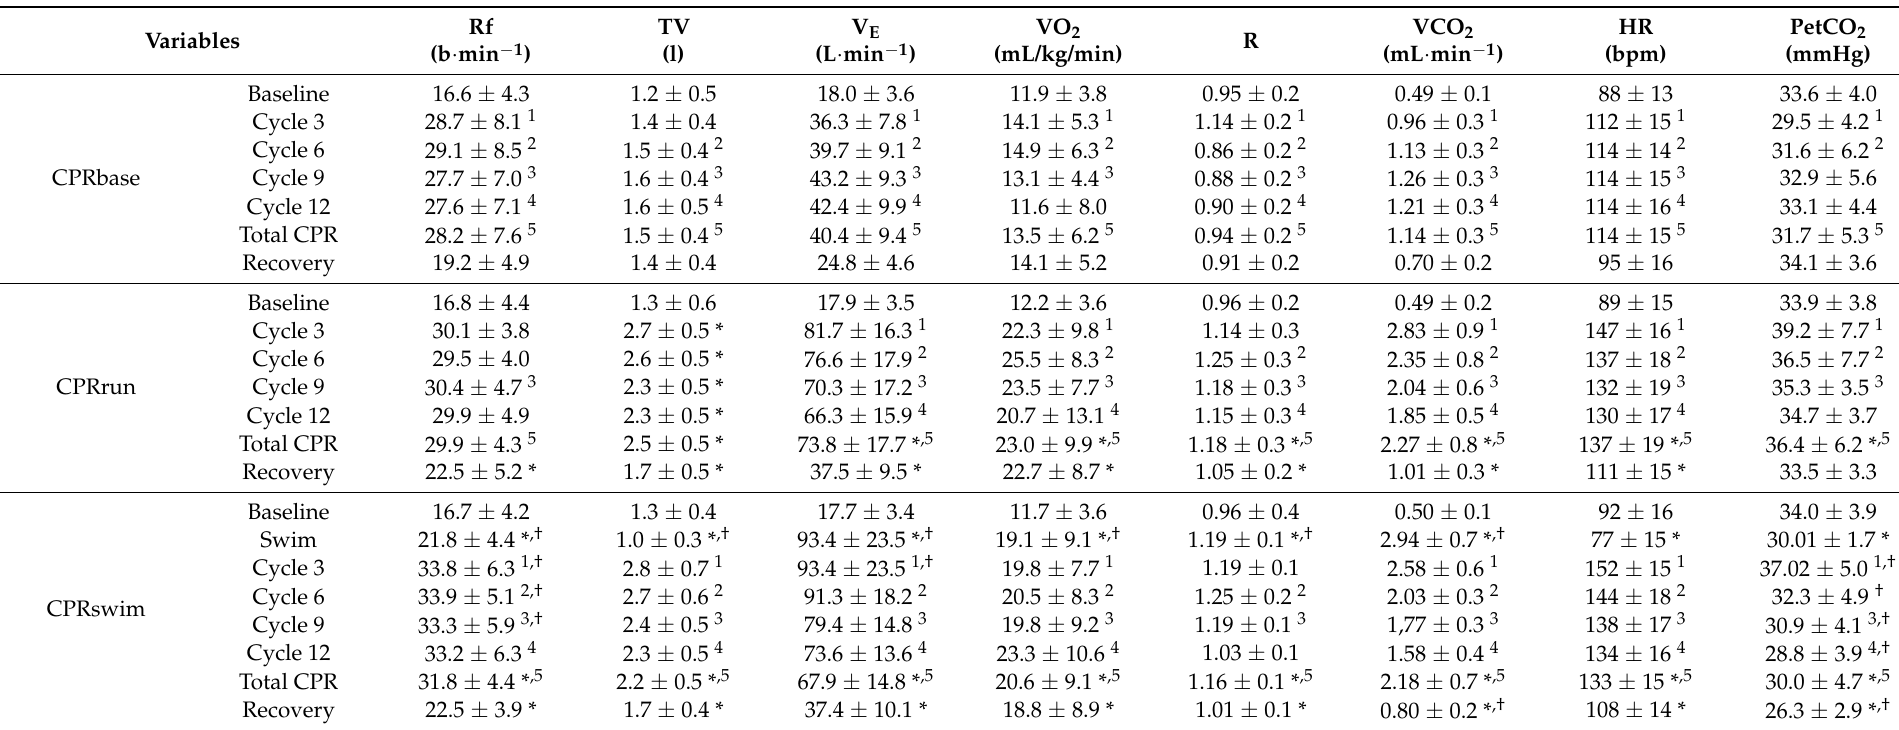
Table 1. Mean ± SD values for the cardiopulmonary variables assessed during baseline, CPR cycles, total CPR and recovery in the different experimental conditions.